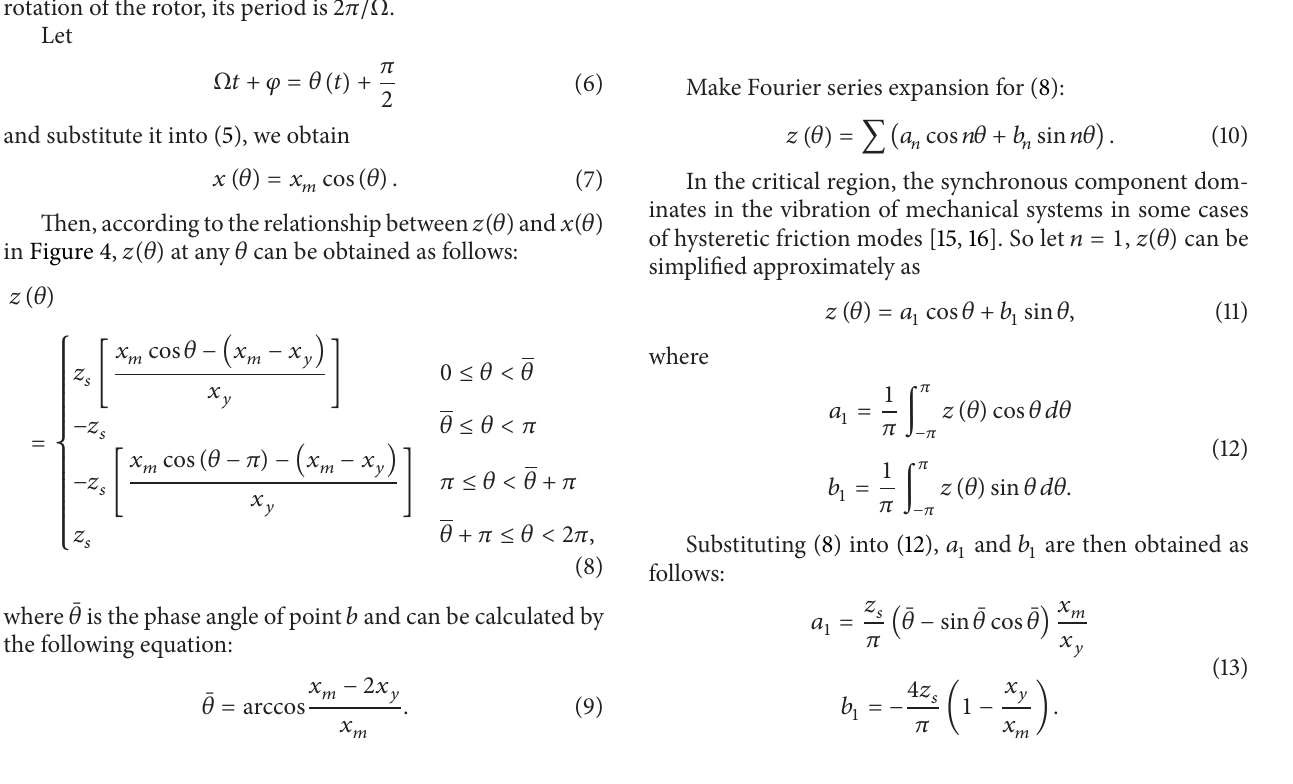
Figure 4: The constitutive relation of the damping force 𝑧(𝜃) (angle